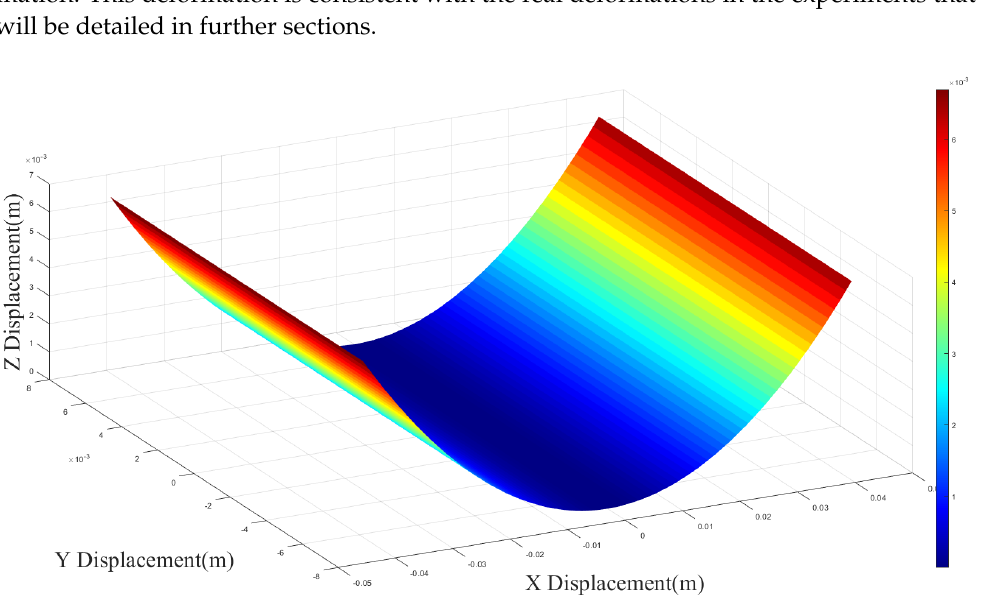
Figure 3. Theoretical Model